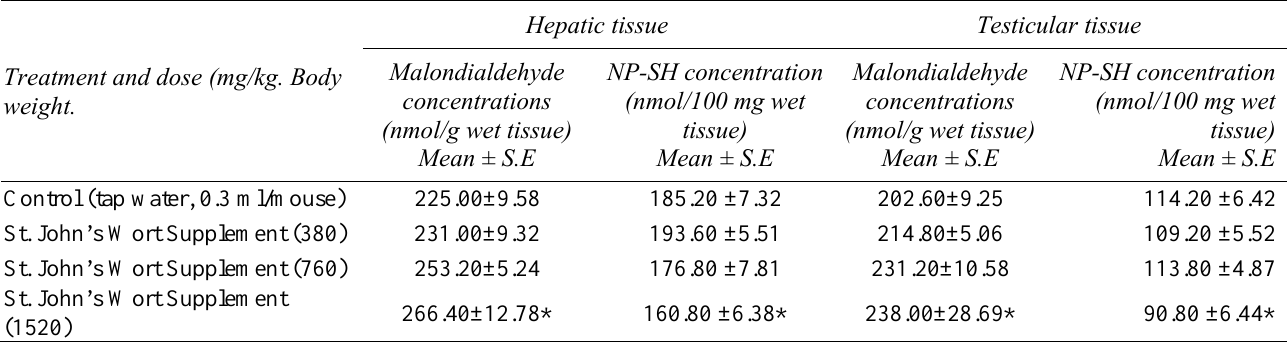
Table 5: Effect of St. John’s Wort Supplement on Malondialdehyde and Glutathione (NP-SH) concentrations in liver and testes of mice after sub-acute treatment